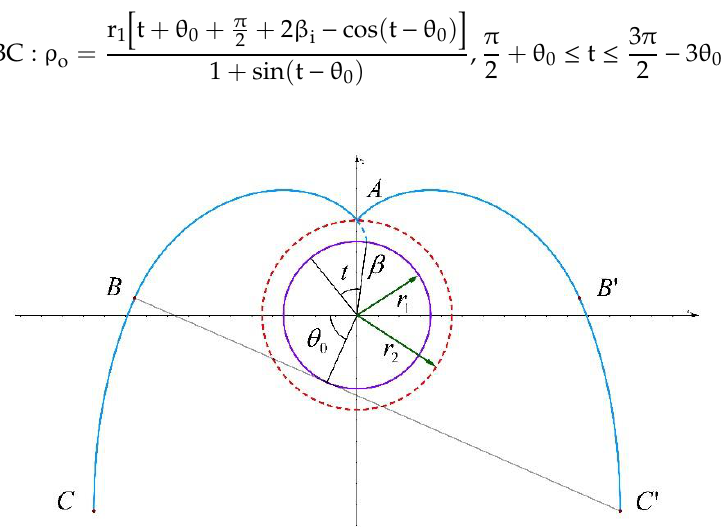
Figure 12. Modified geometry of the compound parabolic concentrator (CPC) with a separate absorber.